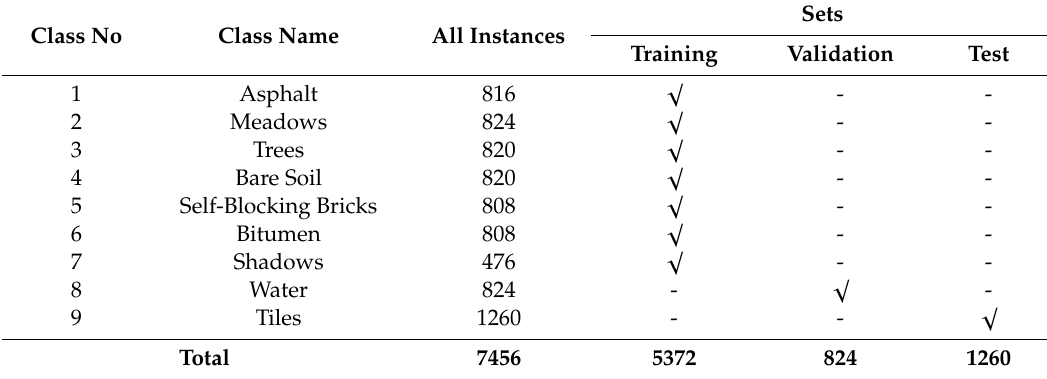
Table 3. Pavia Center dataset.